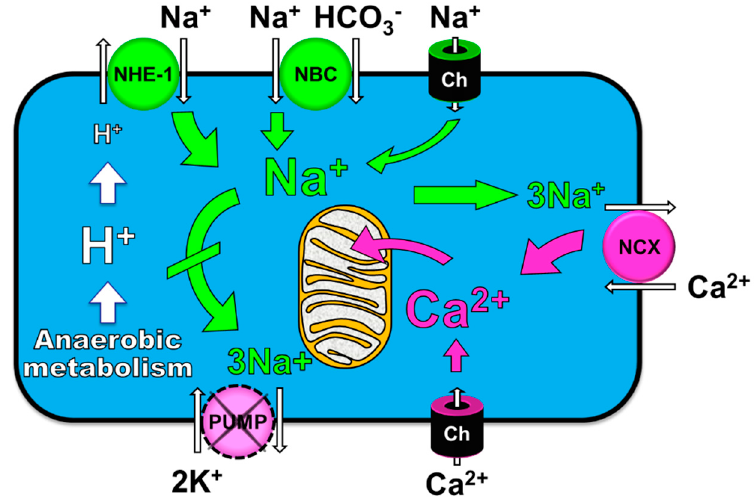
Figure 2. Rendition of a cardiomyocyte during ischemia and reperfusion depicting Na + -induced cytosolic and mitochondrial Ca 2+ overload consequent to ischemia generating intracellular acidosis while the Na + -K + pump is inhibited. Ch, channel; NBC, Na + -HCO 3 − co-transporter; NCX, Na + -Ca 2+ exchanger; NHE-1, sodium– hydrogen exchanger isoform-1.